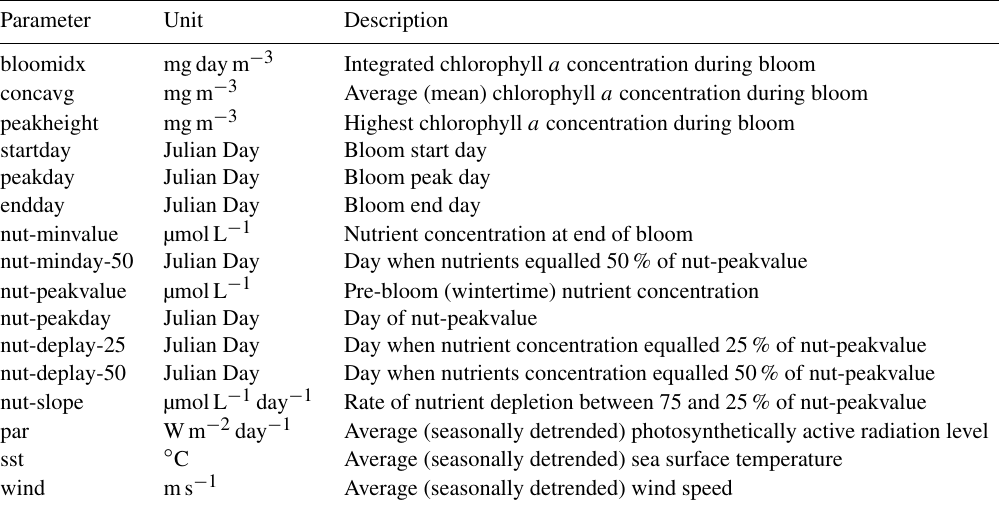
Table 2. Description and acronyms of bloom phenology, nutrient, and meteorological parameters that were used in the trend and multi-variate